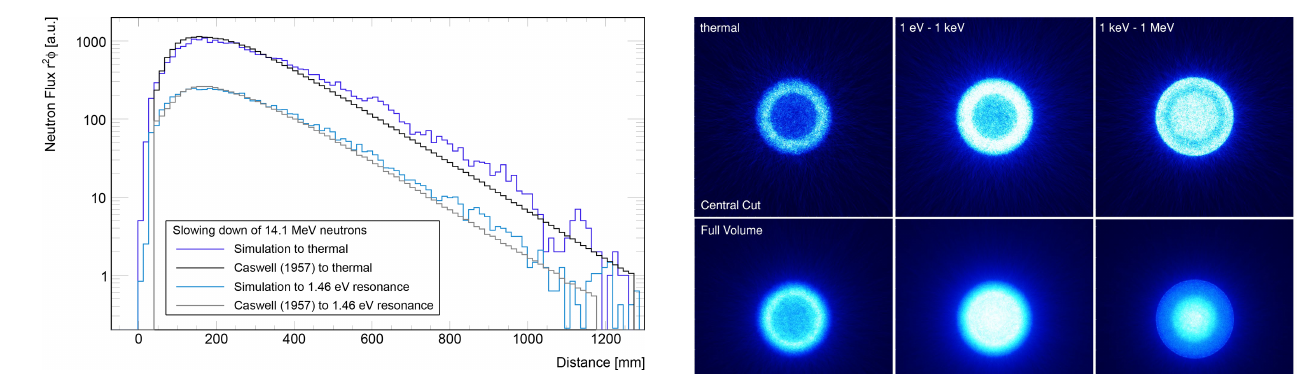
Figure 11. Comparison of the attenuation length from Caswell et al. (1957) for deuterium–tritium fusion neutrons emitted into water. The spherical surface flux for thermal and indium resonance neu- trons as a function of distance from the source is compared to the simulation results from URANOS.